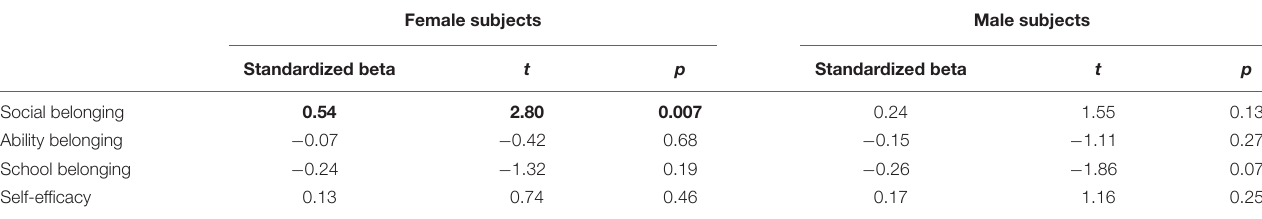
TABLE 5 | Social belonging, ability belonging, school belonging, and self-efficacy predicting intentions to persist in